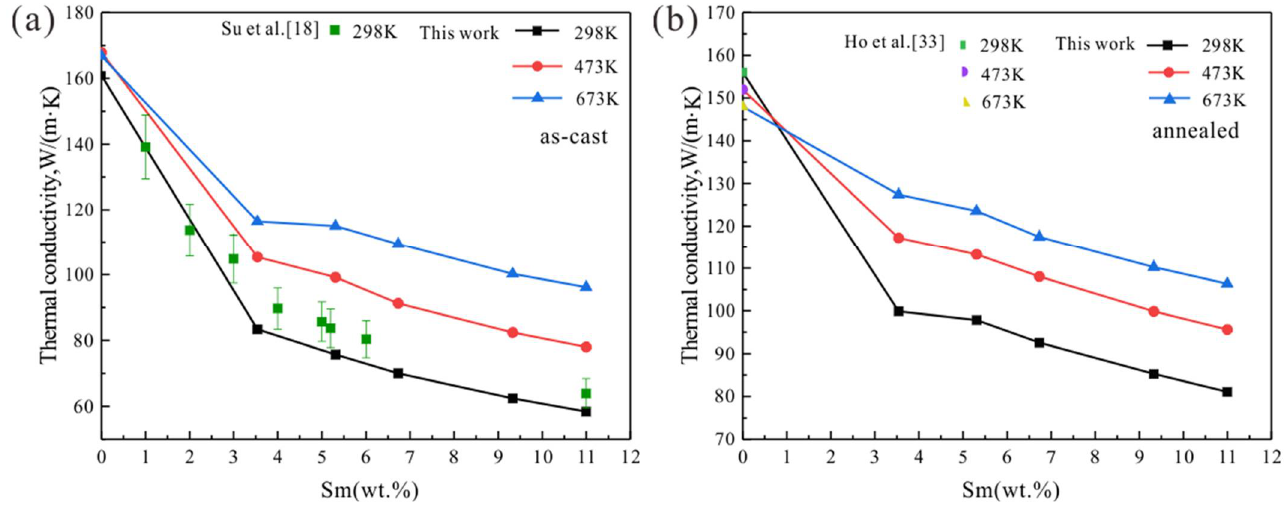
Figure 9. Thermal conductivity of ( a ) as-cast Mg-Sm alloys; ( b ) annealed Mg-Sm